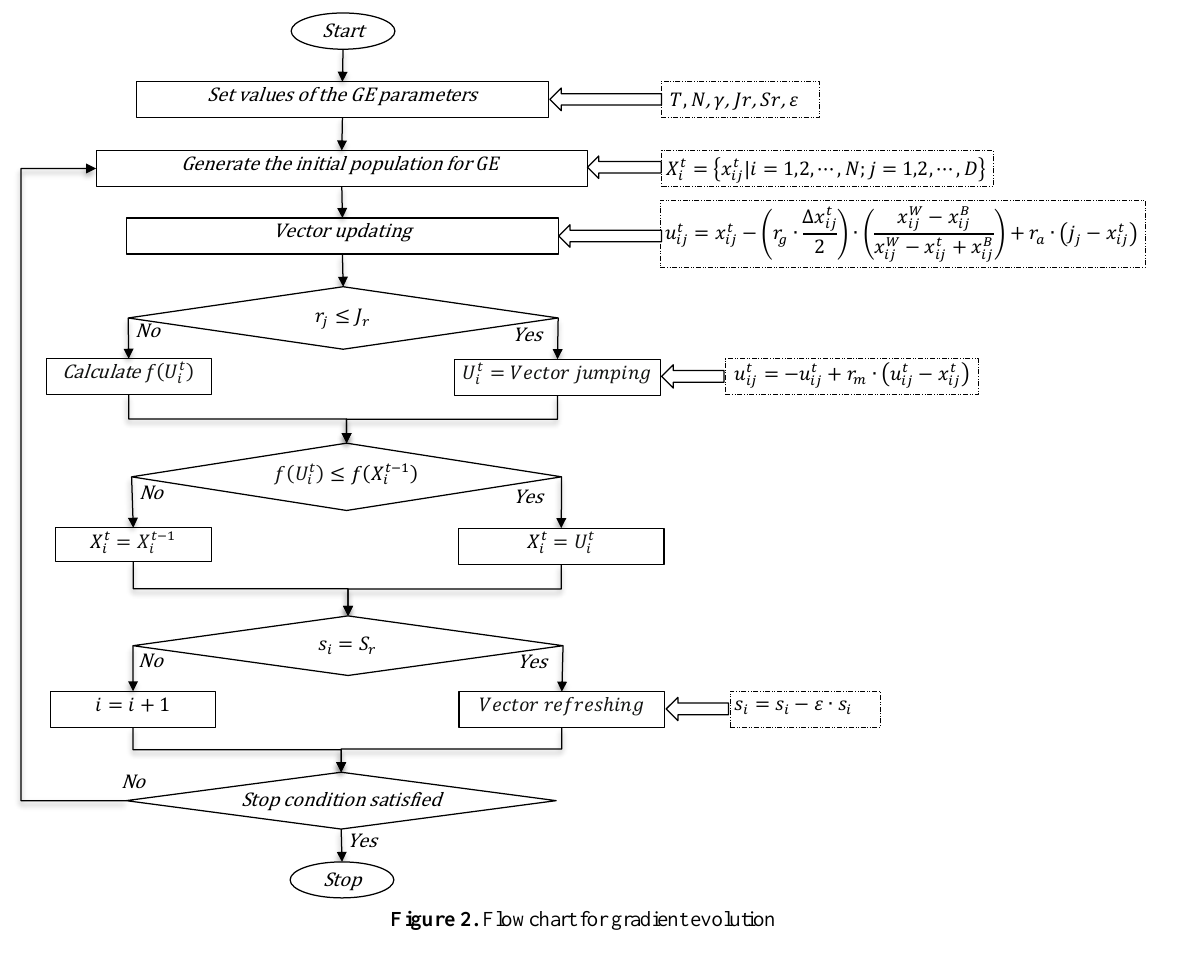
Figure 2. Flowchart for gradient